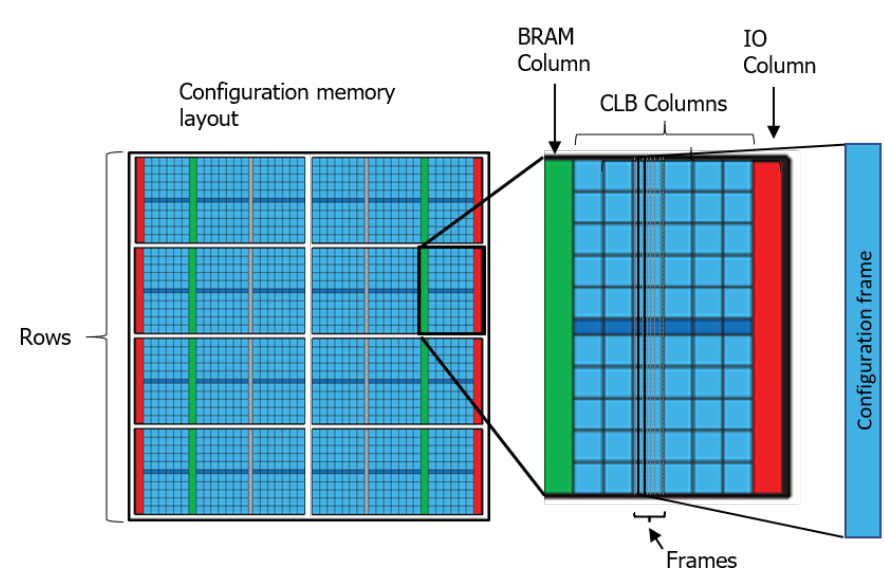
Figure 1. Simplified representation of the configuration memory